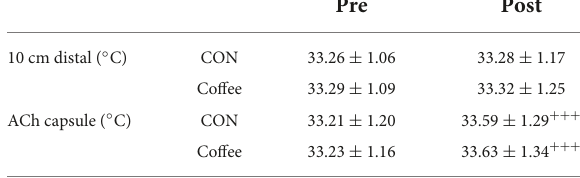
TABLE 1 Comparison of skin temperature 10 cm distal and acetylcholine (ACh) capsule between the CON and Coffee groups in the quantitative sudomotor axon reflex test